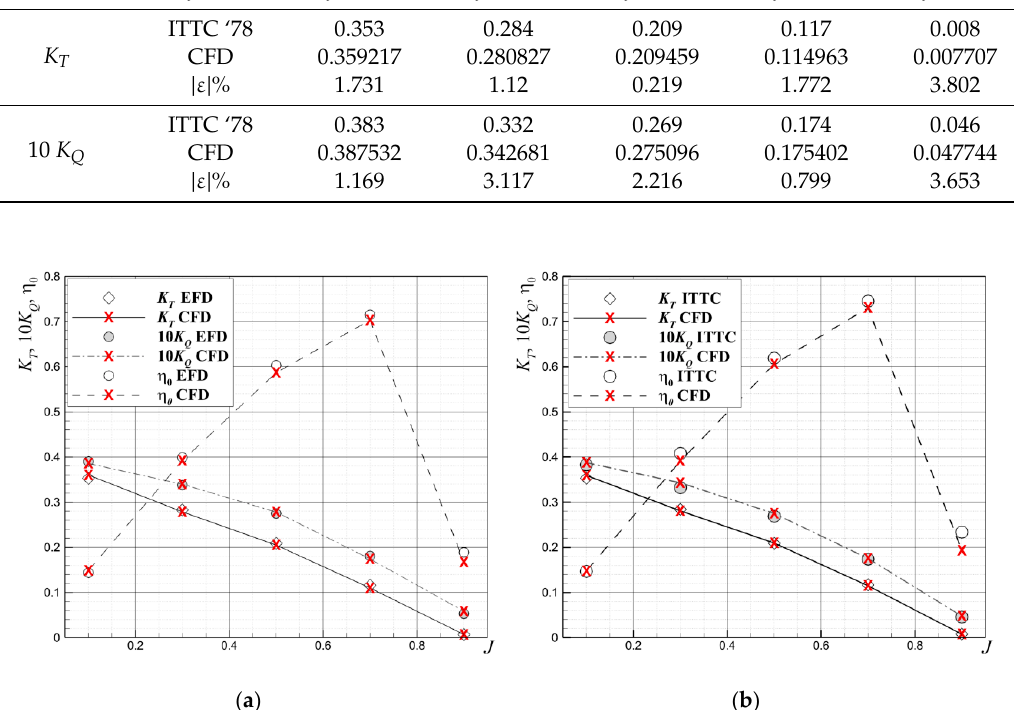
Figure 6. Comparison between the performance curves for the P1727 propeller: ( a ): computed and measured at model scale, provided in [18]; ( b ): computed for the full scale.